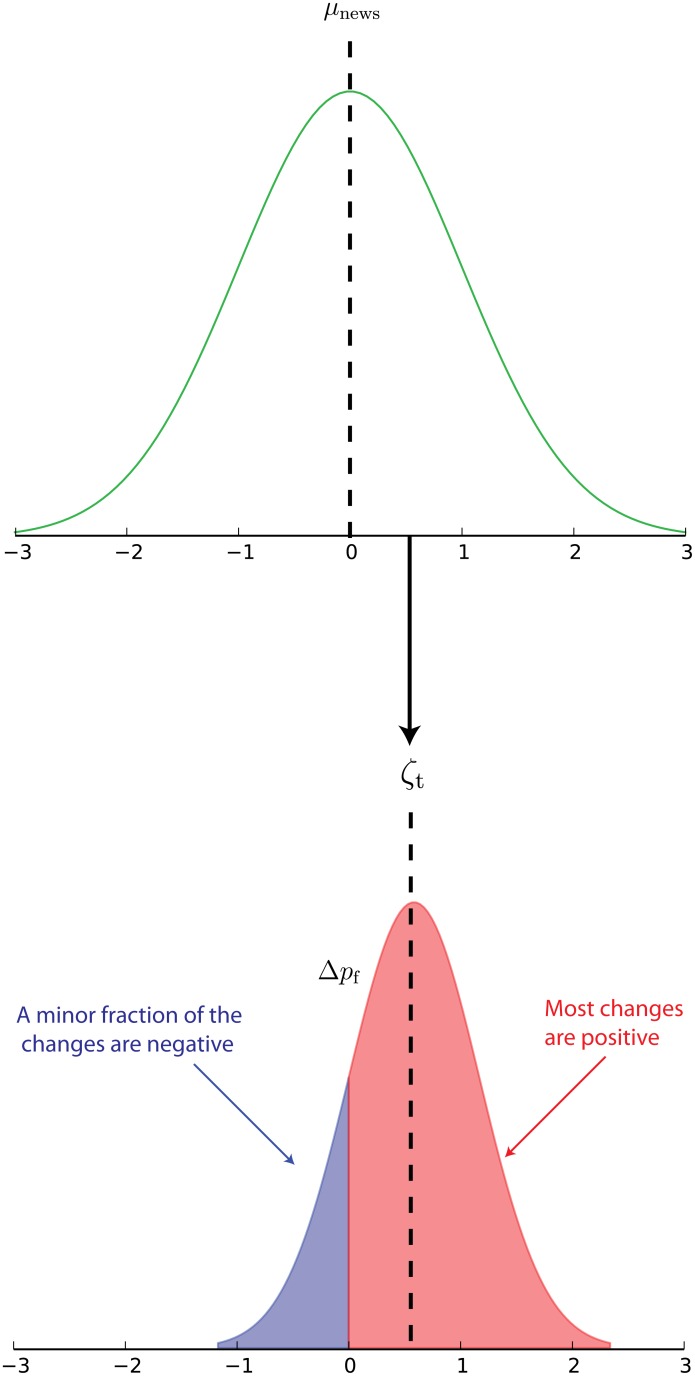
News and their effects on fundamental prices.We model news as a sequence of IID Gaussian random variables. When a realization of this sequence, representing news being issued, occurs, the fundamental prices of each agent are adjusted from pf to pf + Δpf with Δpf extracted from another normal distribution whose mean is equal to the value of the current news. In this way when highly positive news arrive, the majority of fundamental price changes will be positive; conversely, when highly negative news arrive, most price changes will also be negative.